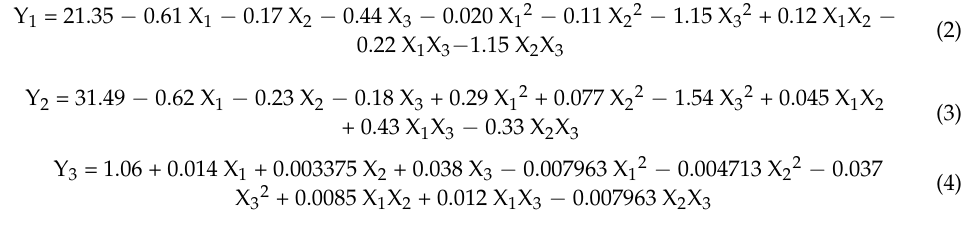
Equations (2)–(4), where Y 1 , Y 2 , and Y 3 represent tensile strength, flexural strength, and flexural modulus, respectively; X 1 , X 2 , and X 3 are CNF loading, rotational speed, and temperature, respectively.